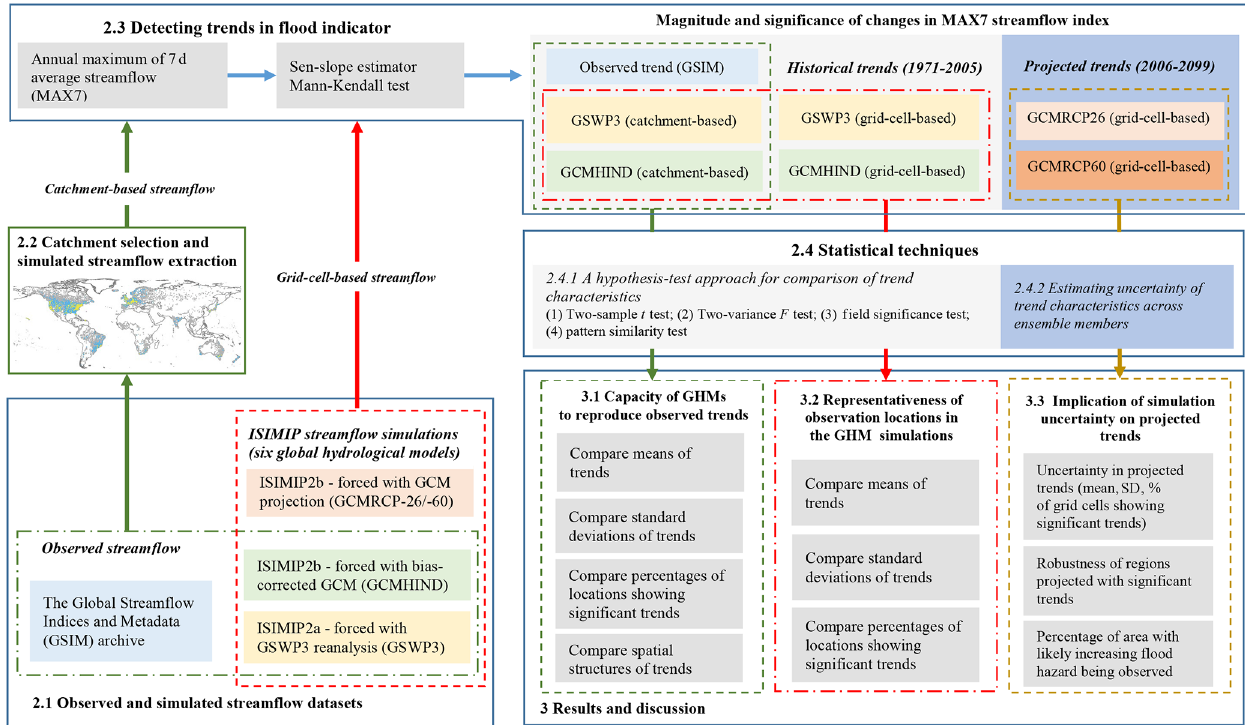
Figure 1. Flowchart of the datasets and methodologies used to achieve three research objectives of this study.